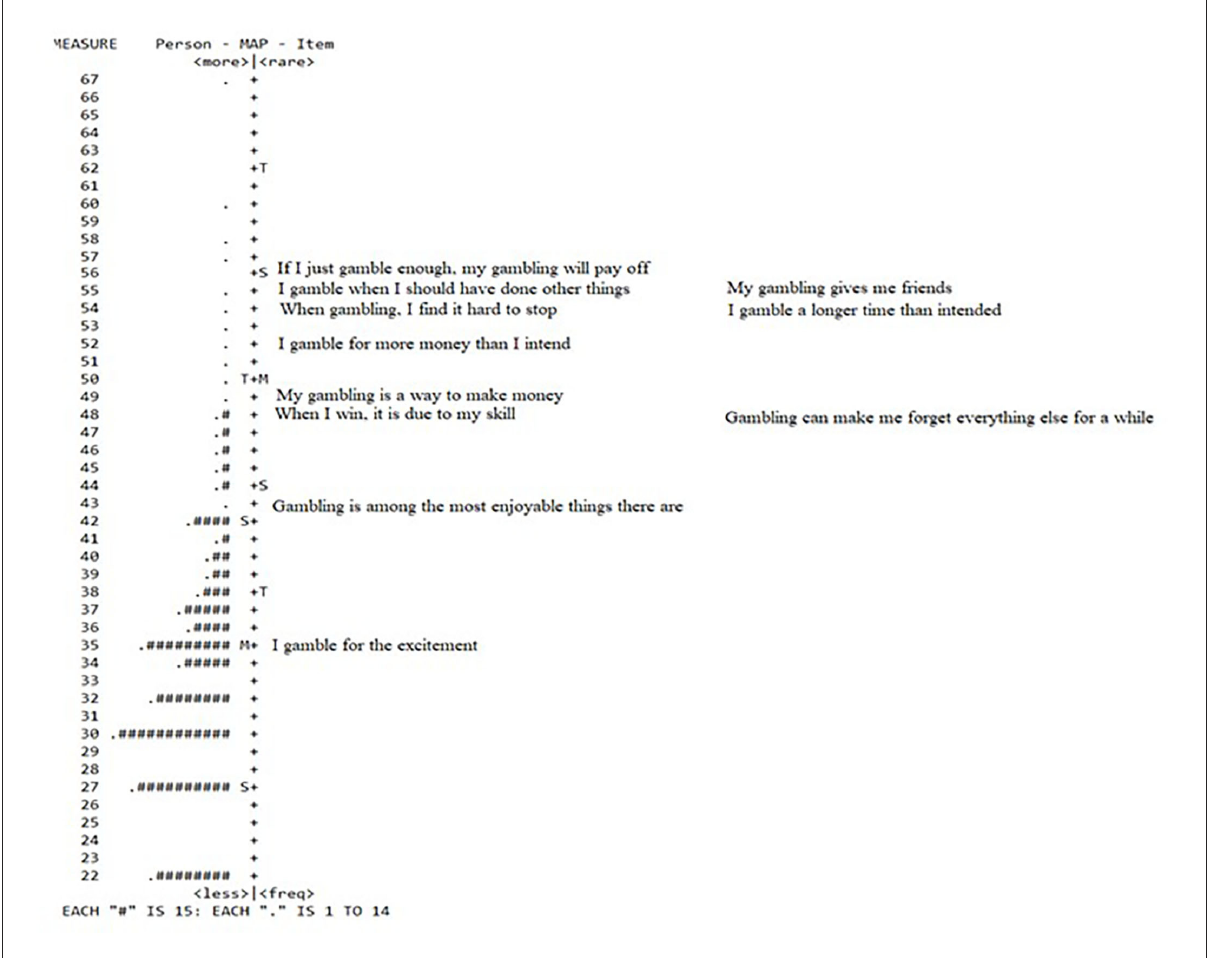
FIGURE2 Person-item map JAS (11